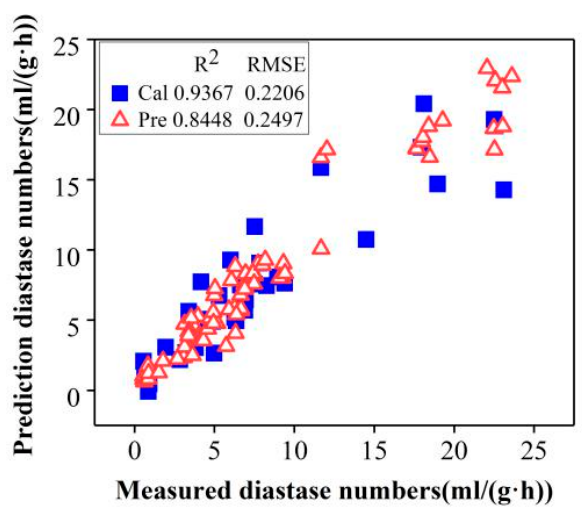
Figure 4. Measured vs. predicted diastase numbers in honeys by GF-SNV-LS-SVM models based on the characteristic wavelengths (Cal and Pre represent calibration and prediction, separately).